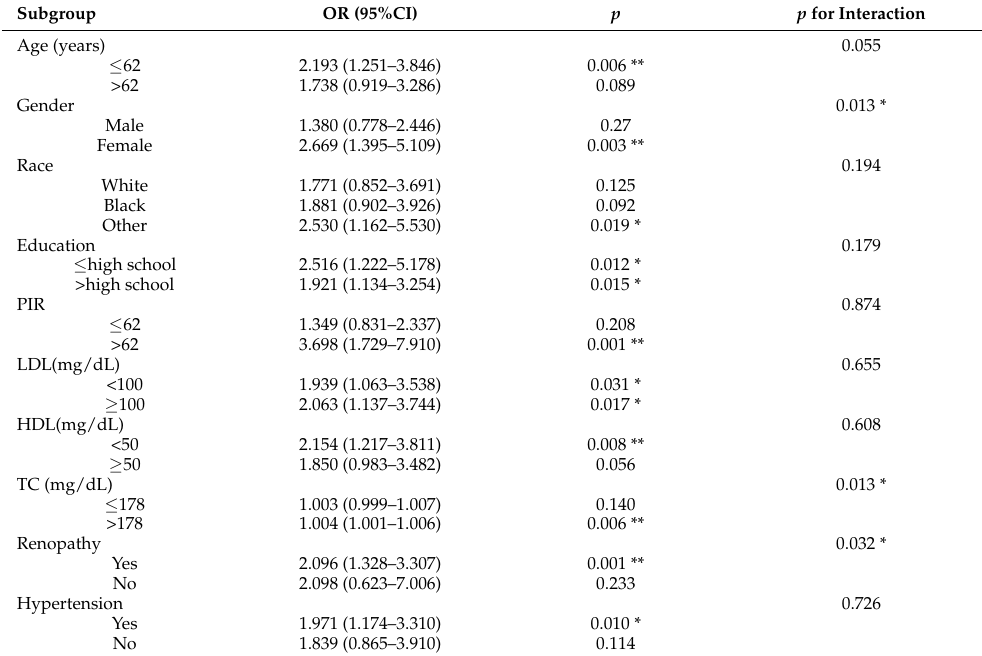
Table 3. Subgroup analysis of the associations between the TyG index and diabetic